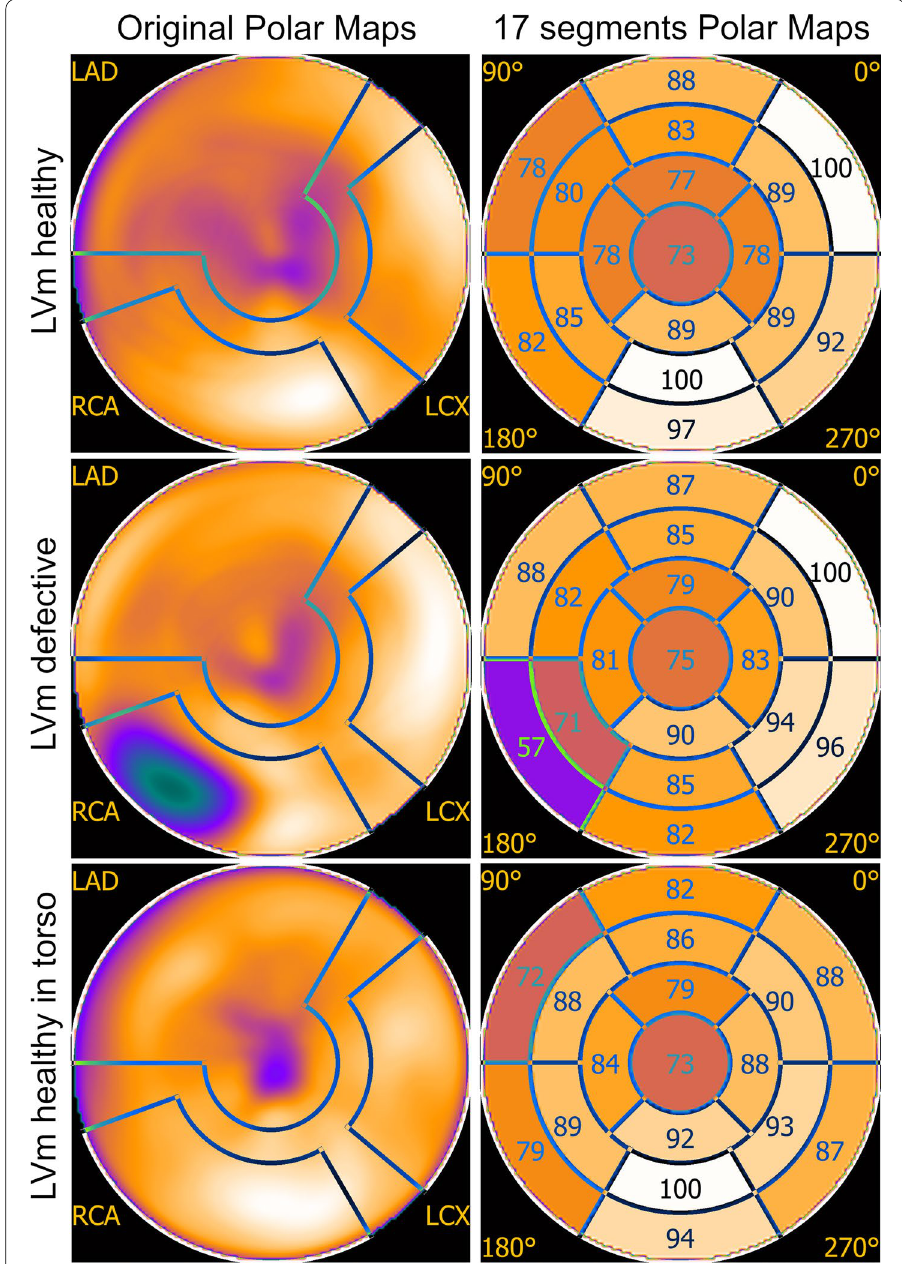
Fig. 9 Original (first column) and 17 segments (second column) polar maps of the three